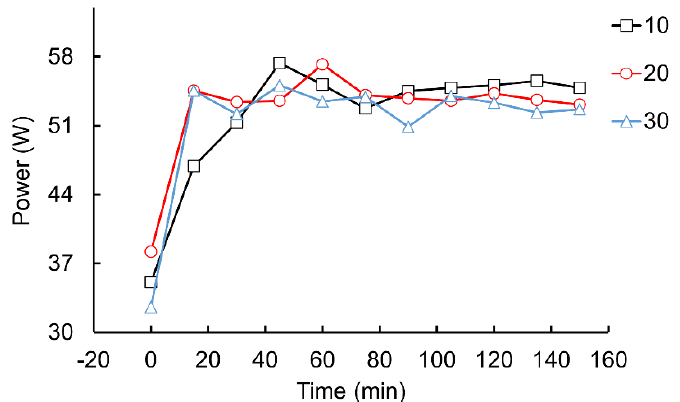
Figure 16. Effect of preload torque of Junction Surface at Straight Edge Knife on Power of Acoustic Vibration Component.